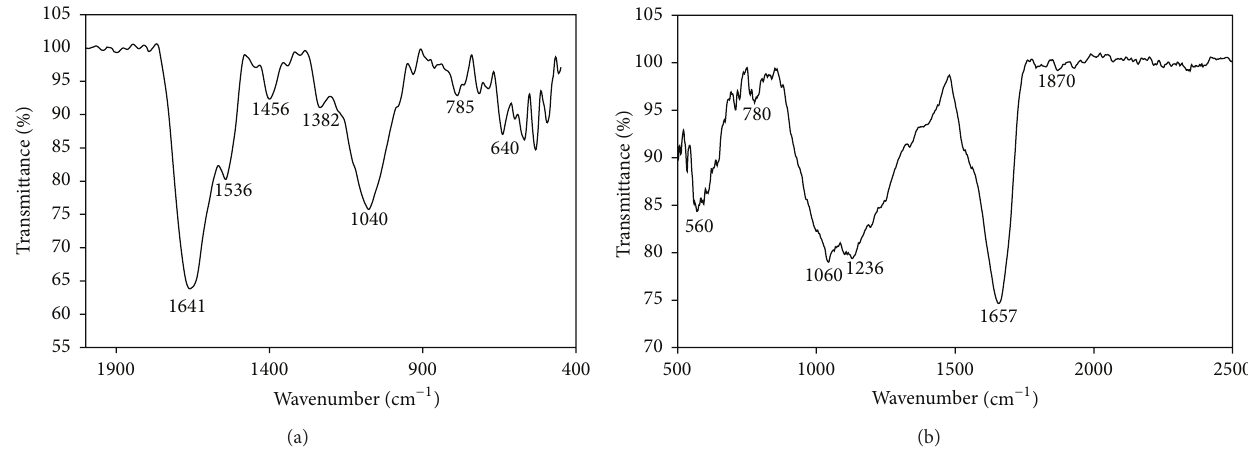
Figure 5: FTIR spectra recorded from powder of sulfide nanoparticles synthesized using K. pneumoniae : (a) CdS and (b)